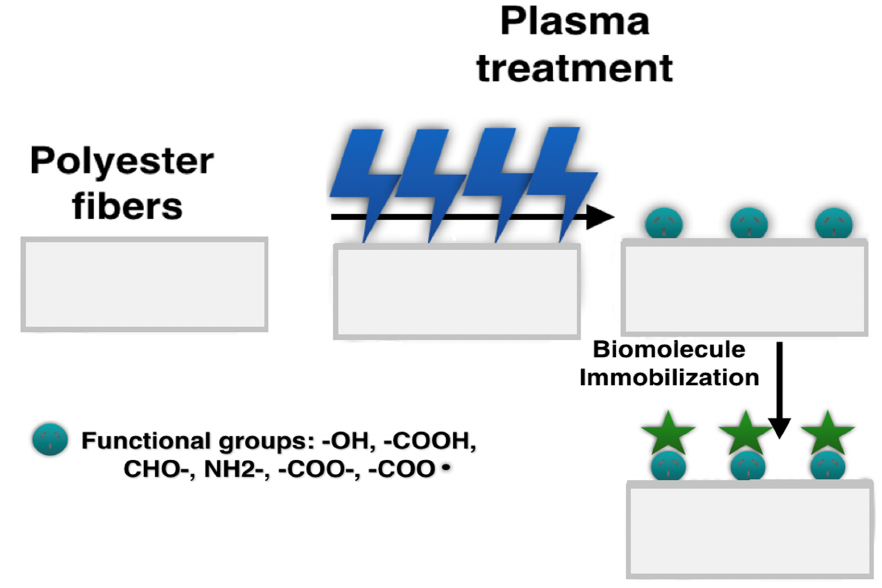
Figure 2. Plasma treatment of electrospun nanofibers.